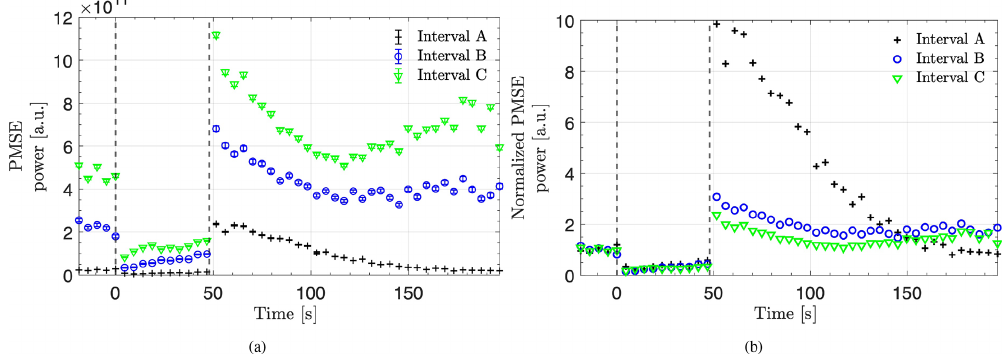
Figure 16. Average overshoot curves for each respective interval (a) and normalized average overshoot curves (b) for the same intervals. They are normalized with the average of the last five values before the heater was turned on.